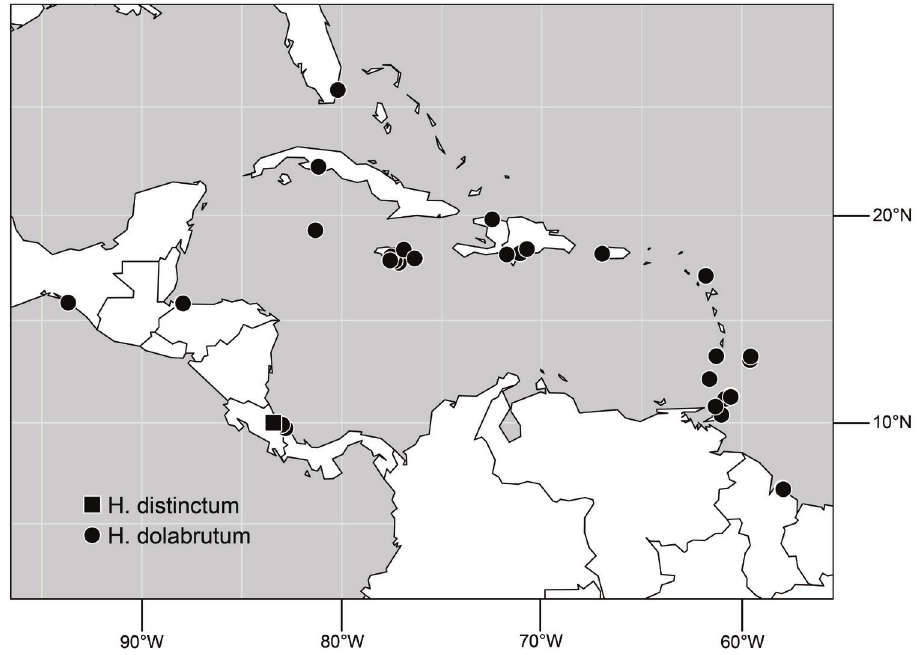
Figure 76. Distribution of Hydrochasma distinctum sp. n. and H. dolabrutum sp.